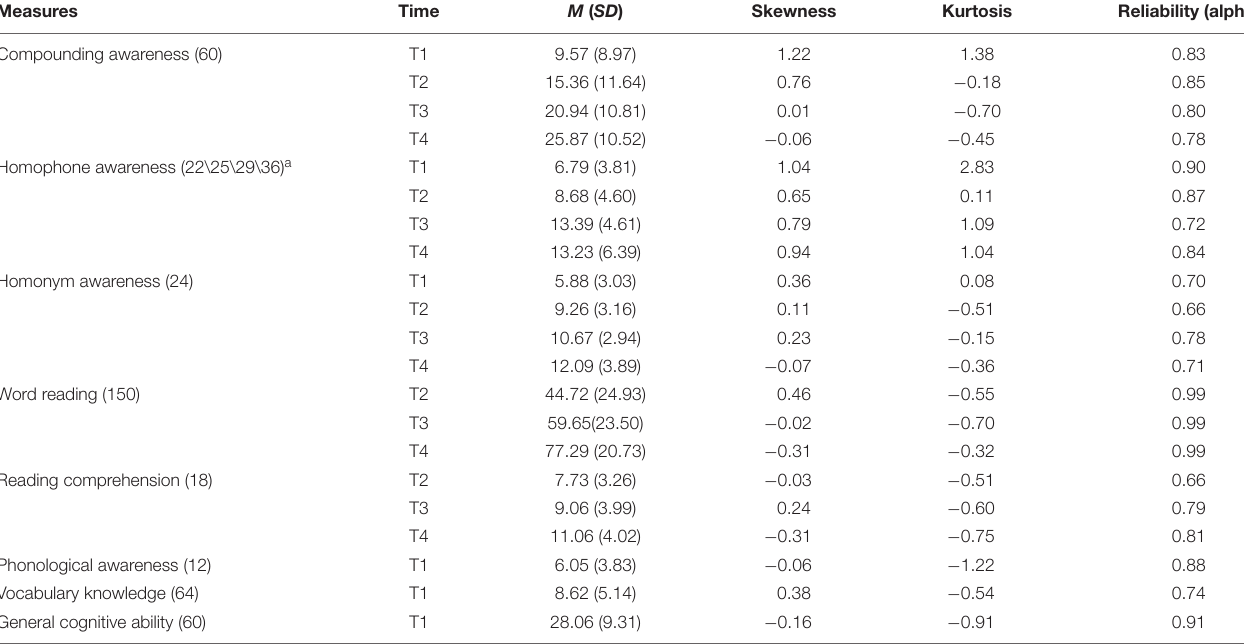
TABLE 1 | Means, standard deviations, skewness, kurtosis, and reliabilities of all measures from T1 to T4. Measures Time M ( SD ) Skewness Kurtosis Reliability